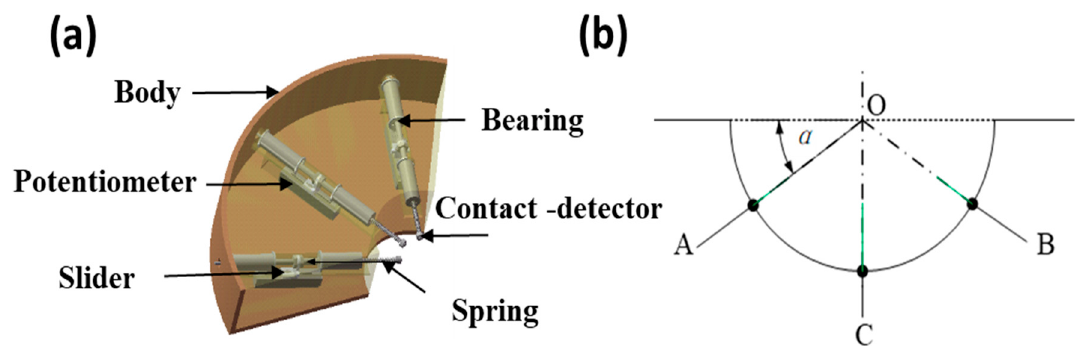
Figure 5. Sensor structure. ( a ) The scheme design of the displacement sensor; ( b ) the position sketch of the sensor through the center.